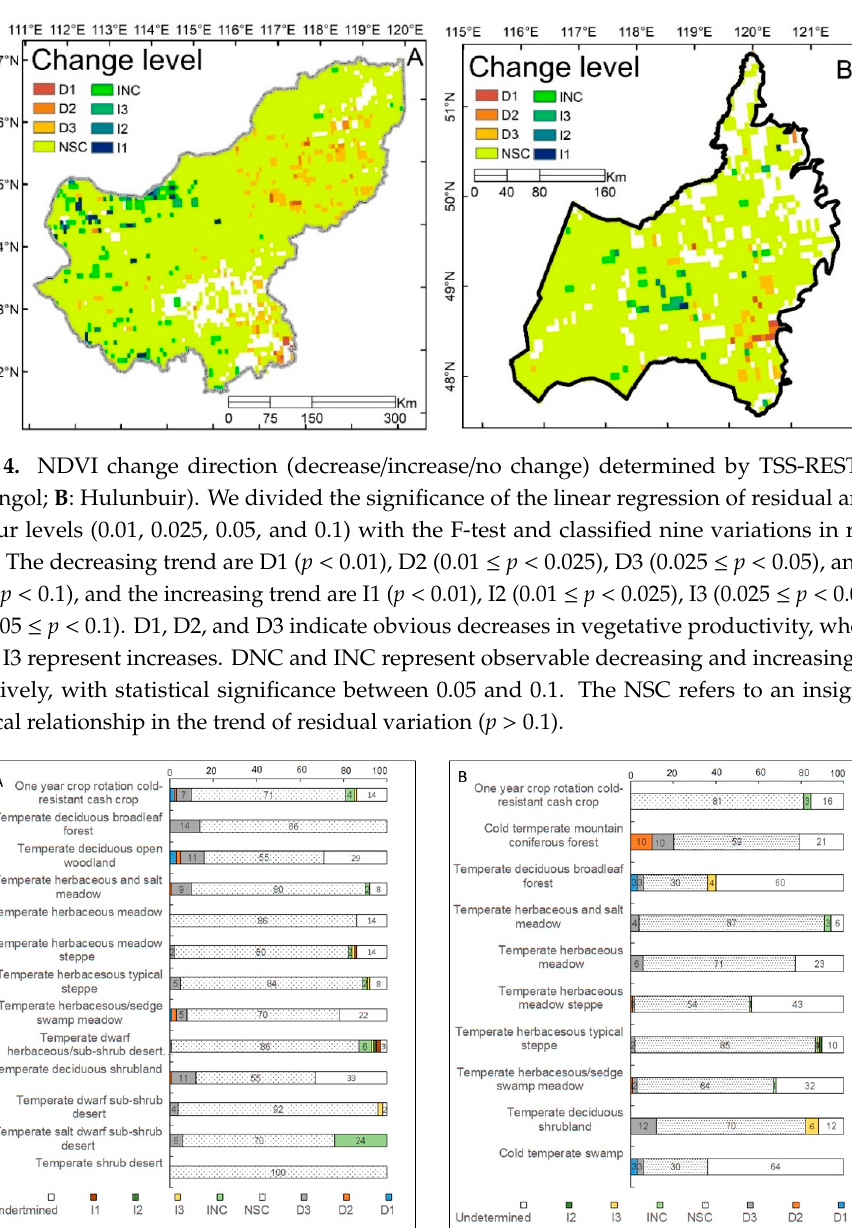
Figure 5. NDVI change direction (decrease/increase/no change) in different vegetation types determined by TSS-RESTREND. ( A : Xilingol; B : Hulunbuir).